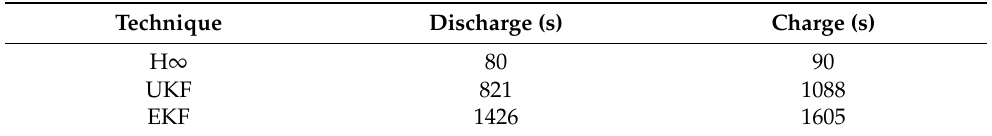
Table 3. Convergence time of charge and discharge SOP estimation of SOC based on H ∞ , UKF, and EKF algorithm in 30 s time